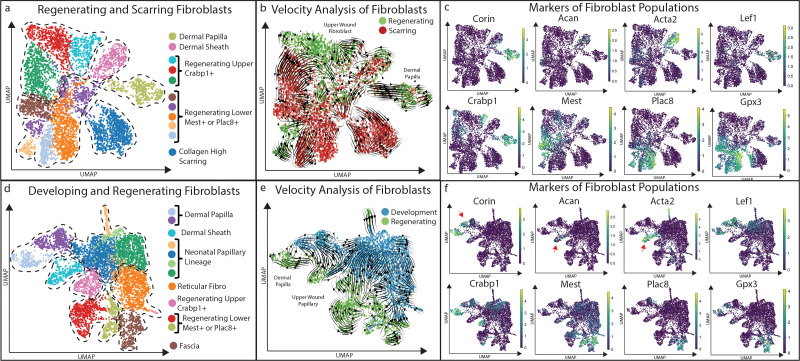
Clustering and Velocity analysis of regenerating, scarring, and developing fibroblasts.(a) Comparative clustering analysis of regenerating and scarring fibroblasts projected as a UMAP. (b) Velocity analysis of regenerating and scarring fibroblasts. (c) Expression analysis of fibroblast markers in regenerating and scarring fibroblasts. (d) Comparative clustering analysis of developing and regenerating fibroblasts projected as a UMAP. (e) Velocity analysis of developing and regenerating fibroblasts. (f) Expression analysis of fibroblast markers in developing and regenerating fibroblasts.